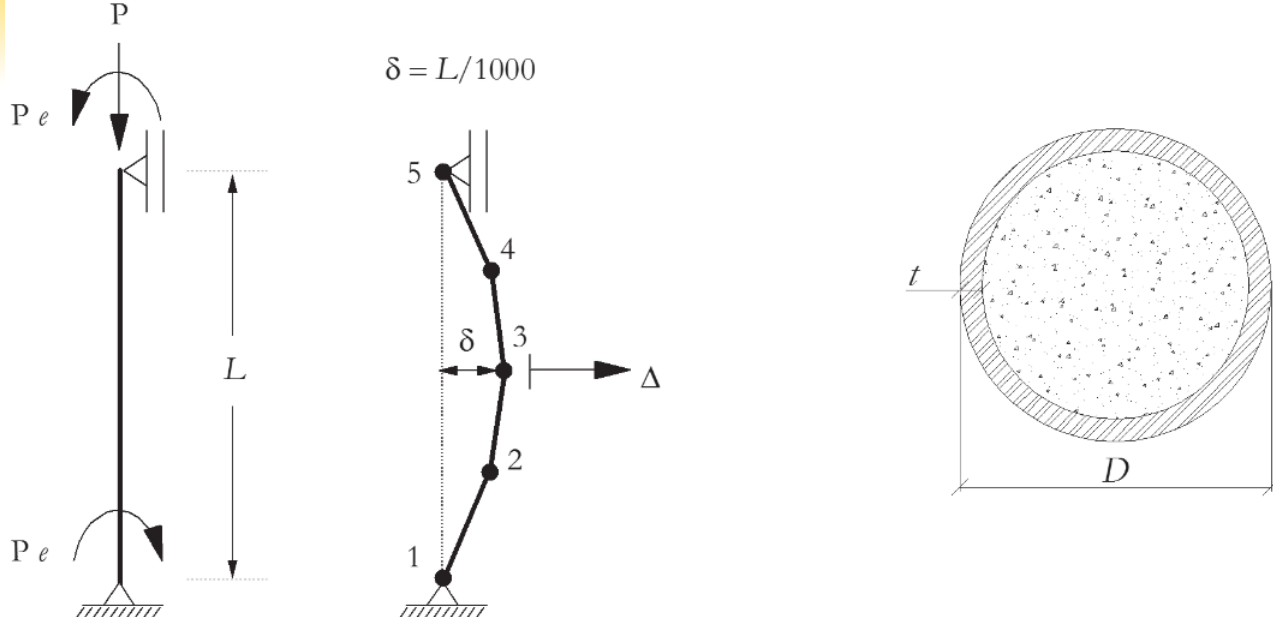
Idealized model for circular composite column with eccentric load analysis